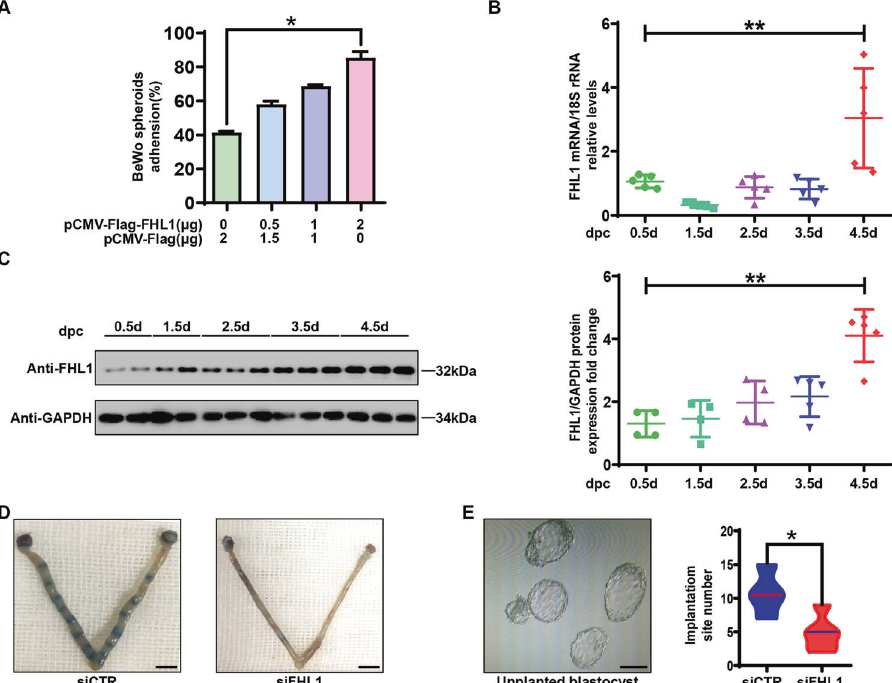
Fig. 3 FHL1 is crucial for blastocyst-epithelial adhesion. A BeWo spheroids (150 – 200 μ m in diameter, 50 per group) were attached to Flag- FHL1-transfected Ishikawa cells after 2 h of coculture. The percentage of BeWo ball adhesion ef fi ciency was calculated. The average of three independent experiments was taken. * P < 0.05, by one-way ANOVA. B The relative expression of FHL1 mRNA in the peri-implantation phase of mice was measured by qRT – PCR. The 18S gene was used as a loading control. ** P < 0.01, by one-way ANOVA. C Western blot analysis to detect FHL1 in the peri-implantation phase of mice. Normalization was performed against the GAPDH protein as a housekeeping protein. ** P < 0.01, by one-way ANOVA. D , E FHL1 protein expression in mice was disrupted with siRNA against FHL1 (siFHL1) or a nonsilencing control (siNC). The expression of FHL1 in the siFHL1 group ( n = 5) and siNC group ( n = 4) was detected by Western blotting. Uteri from siFHL1 and control mice at 4.5 days of gestation were collected and stained with Chicago blue dye. The uterus was fl ushed, and unimplanted blastocysts were counted under a light microscope. * P < 0.05, by Student ’ s t test. Scale bar = 1 cm and 250 μ